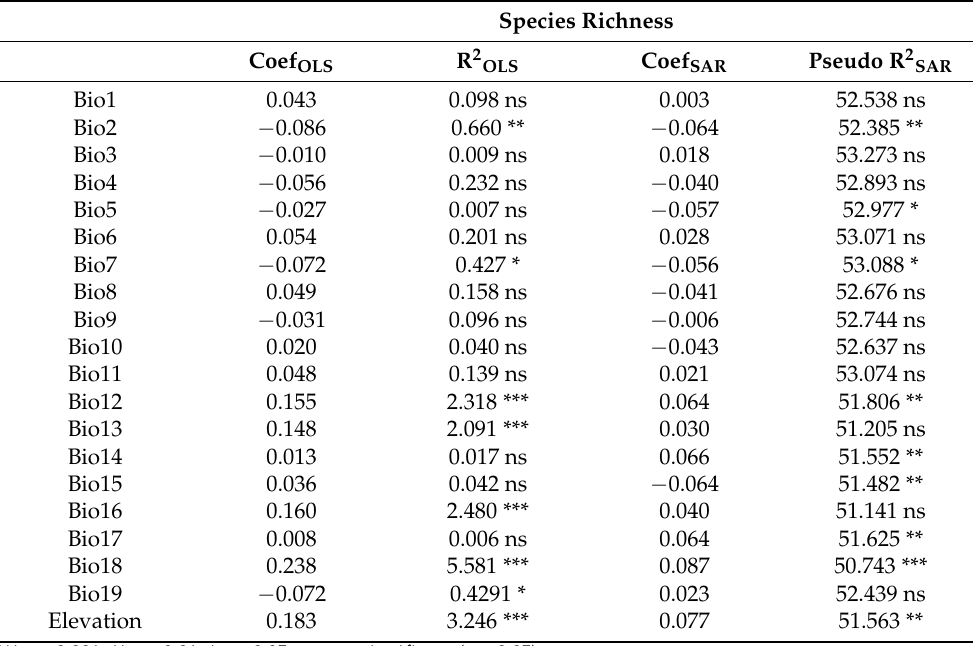
Table 2. Correlations between species richness and environmental factors calculated by spatial error simultaneous autoregressive (SARerr) model and ordinary least squares (OLS) model. Coef, coefficient of regression; R 2 (%), determination coefficient for the OLS model; and pseudo R 2 (%), determination coefficient for the SARerr model.